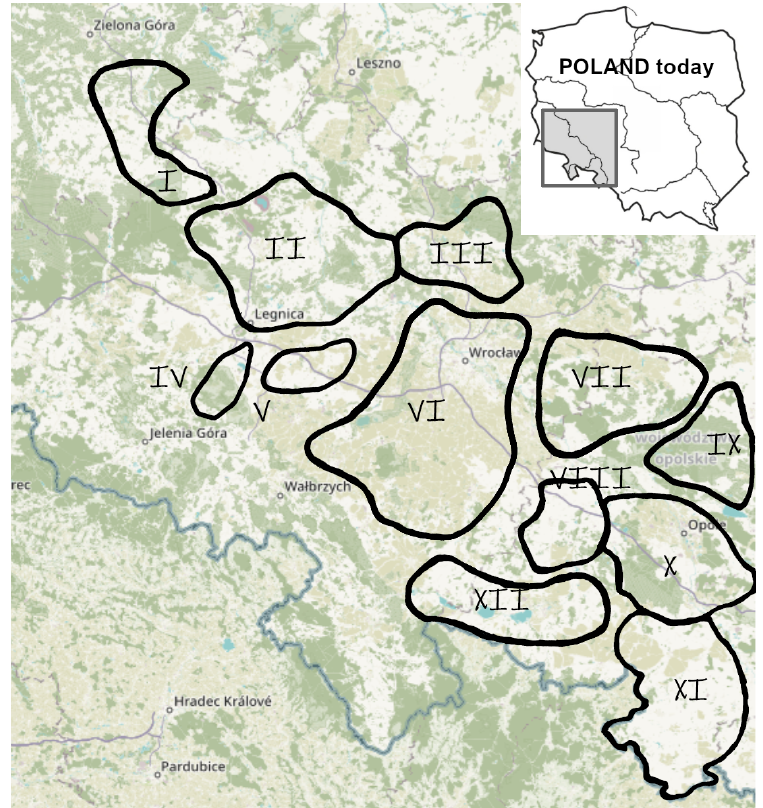
Figure 4. Location of sites with traces of ancient iron ore mining and metallurgy in the regions pro- posed by P. Madera: I—głogowski; II—dolnobarycko-odrza´nski; III—górnobarycki; IV—kaczawski; V—´sredzki; VI—bystrzycko-oławski, VII—widawski; VIII—brzeski; IX—stobrawski; X—strzelecko- opolski; XI—głubczycki; XII—nyski (own